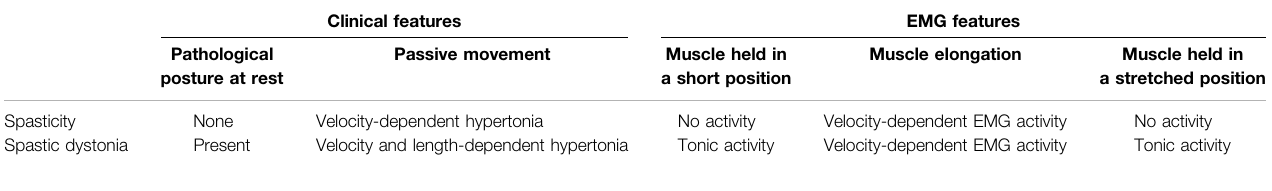
TABLE 1 | Difference between spasticity, and spastic dystonia. Subject is asked to stay completely relaxed during assessment. Clinical